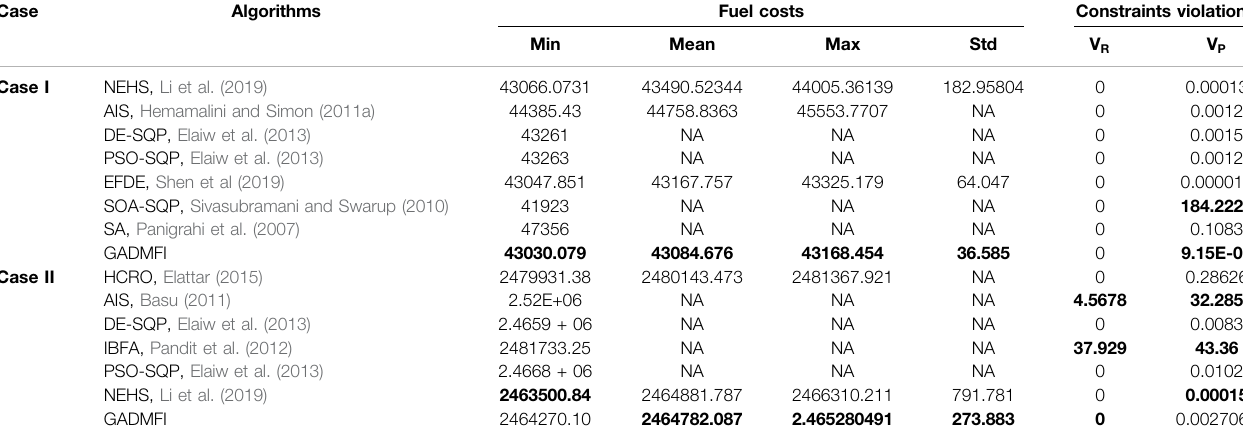
TABLE 9 | Speci fi c results of several algorithms for solving the DED without PEVs problem.